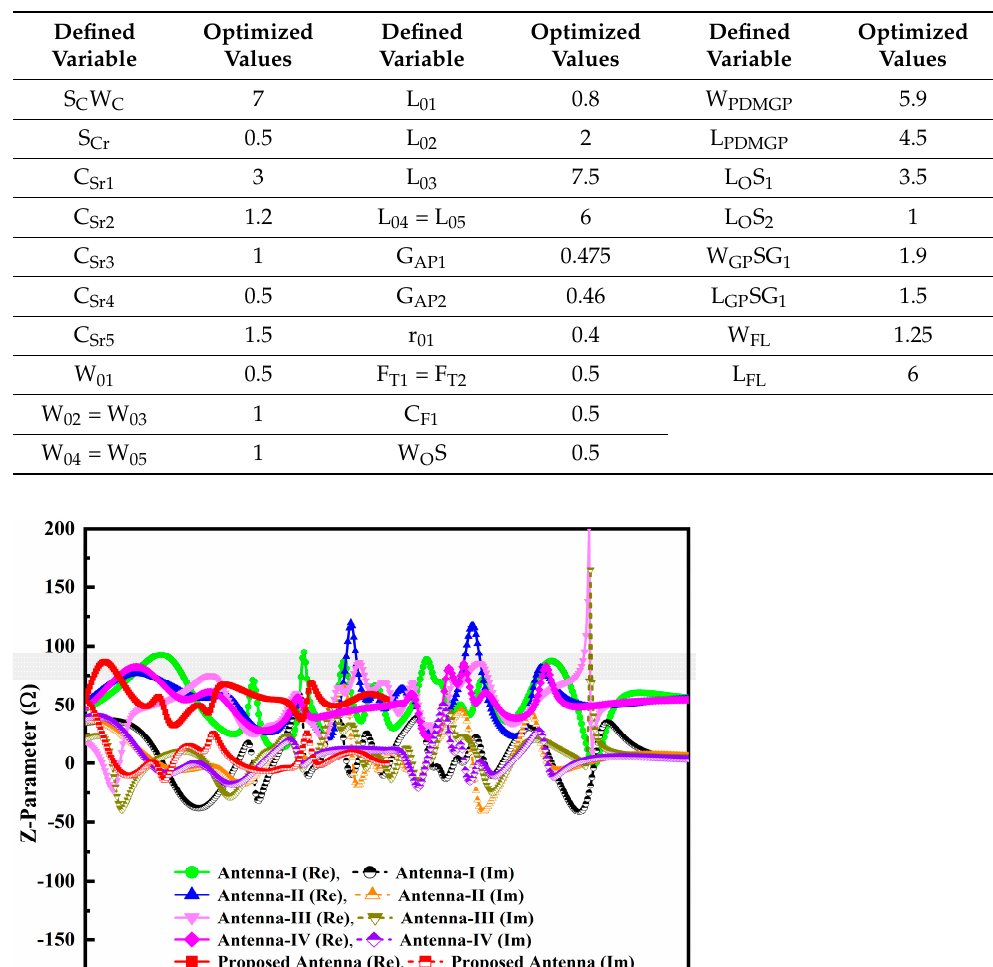
Table 1. Proposed antenna variables and optimized values (unit: mm).